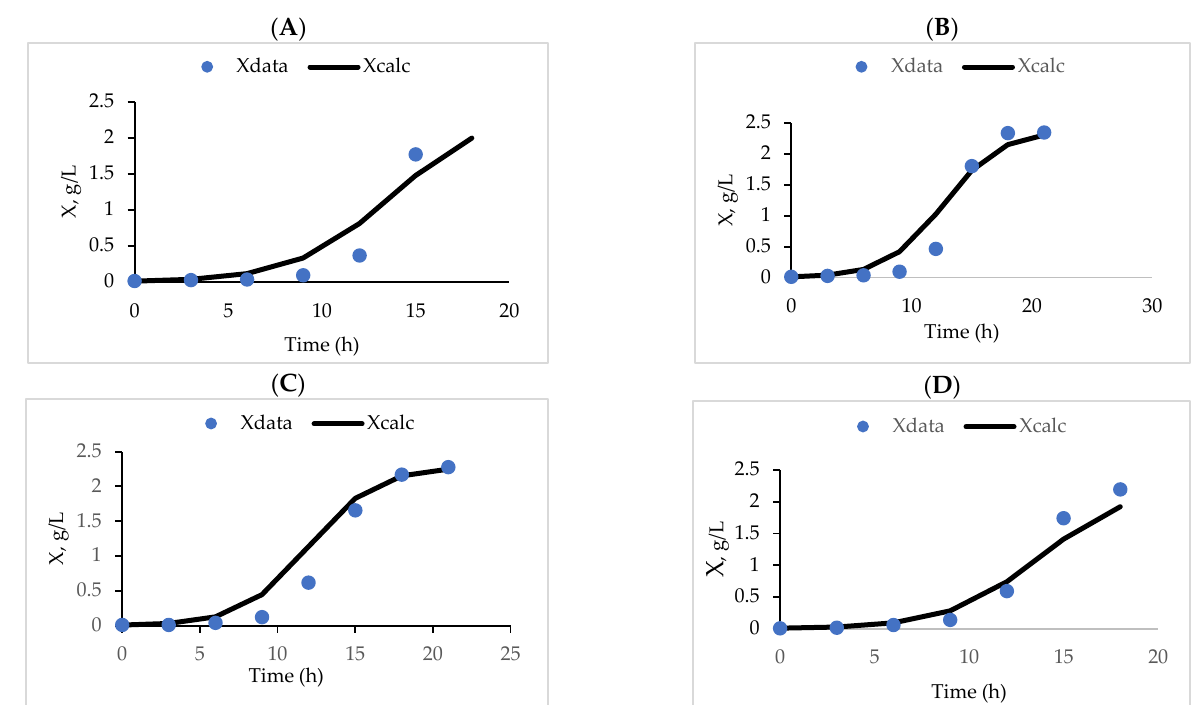
Figure 4. Logistic equation fitting on the four K. marxianus isolates: ( A ) KFA 3, ( B ) KFA 7, ( C ) KFA 9 and ( D ) KFB 1. Table 3. Fermentation kinetics of K. marxianus strains.